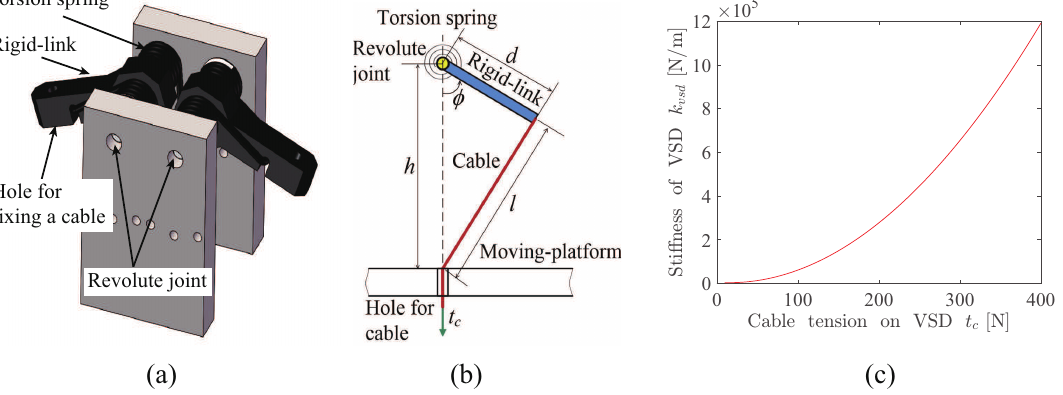
Figure 5. variable-stiffness device (VSD) for simulation: ( a ) CAD model of the VSD, ( b ) diagram of the VSD, ( c ) stiffness–tension curve of the VSD.